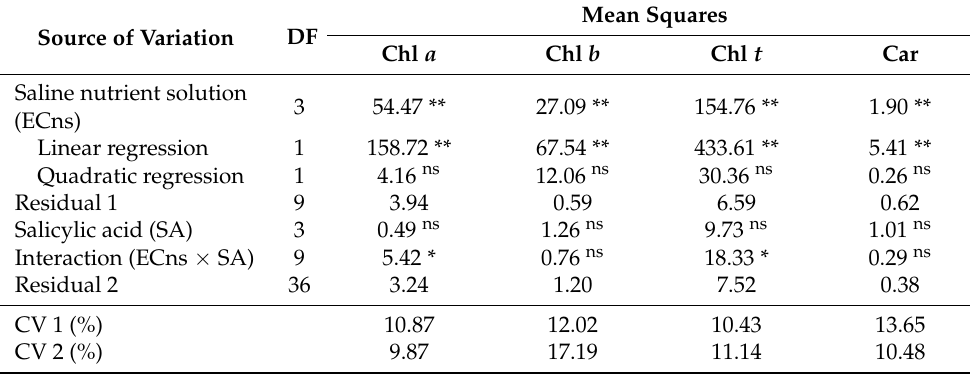
Table 3. Summary of the analysis of variance (ANOVA) for chlorophyll a (Chl a ), chlorophyll b (Chl b ), chlorophyll total (Chl t ), and carotenoids (Car) of Japanese cucumber grown in a hydroponic system with saline nutrient solution and foliar application of salicylic acid, 40 days after transplanting. Mean Squares Source of Variation DF Chl a Chl